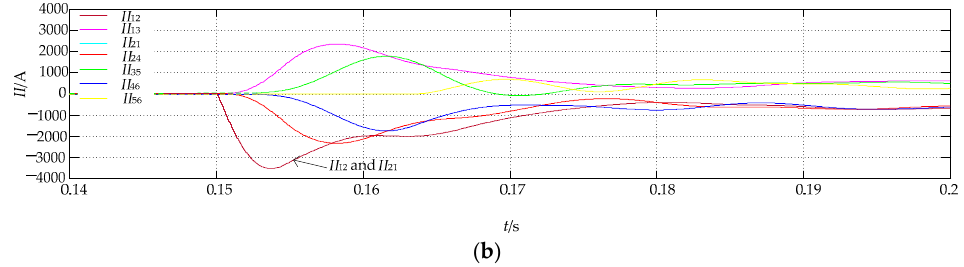
Figure 12. Pole ‐ to ‐ pole short ‐ circuit fault condition: ( a ) Positive line current conditions; ( b ) Negative line current conditions.